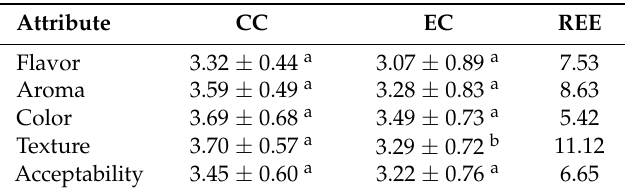
Table 7. Sensory analysis of the control and the experimental Manchego cheese by the effect of the β -CD. Flavor, arome, color, texture and acceptability were evaluated on a five point scale (1 = poor to 5 =